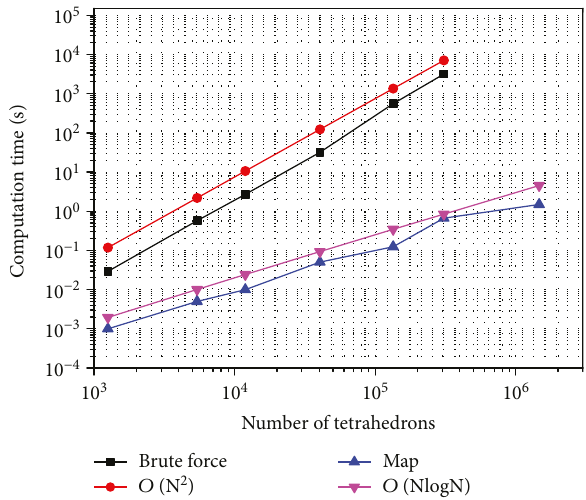
Figure 3: Computation time of constructing SWG pairs versus the number of